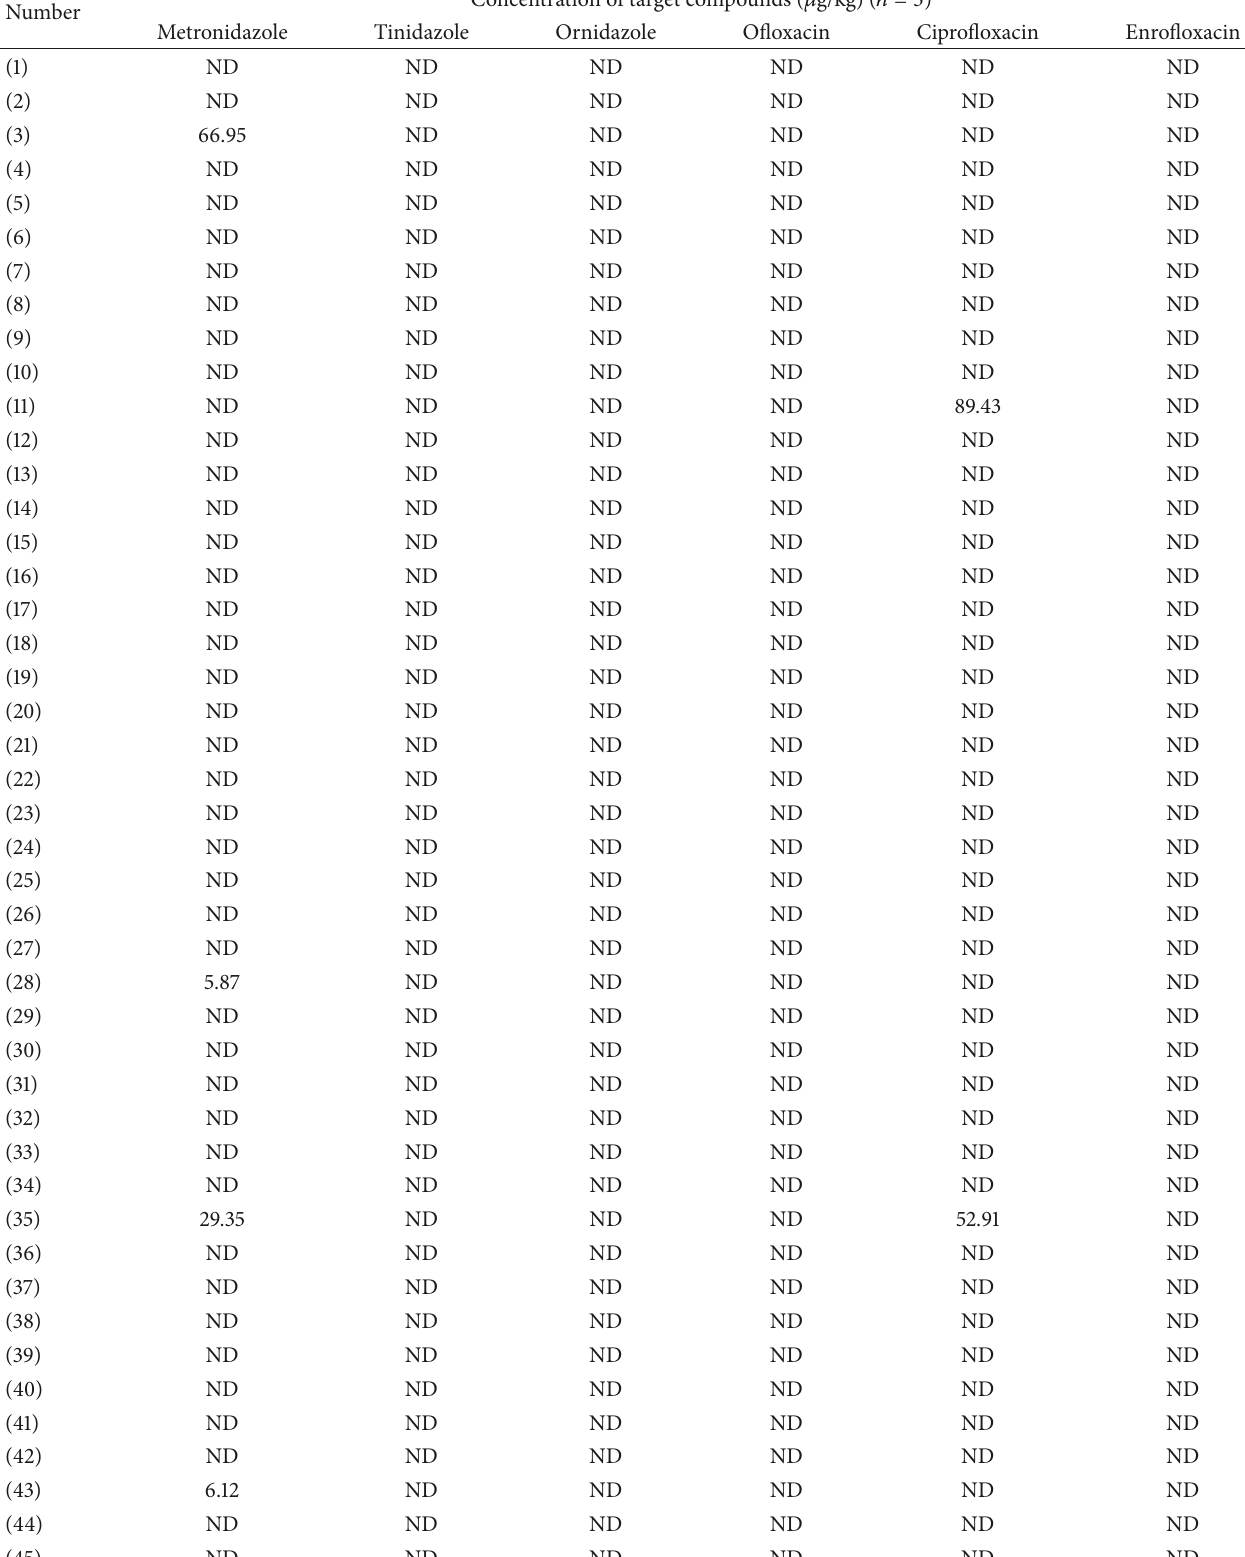
Table 6: Concentrations of antibiotics detected in acacia and jujube